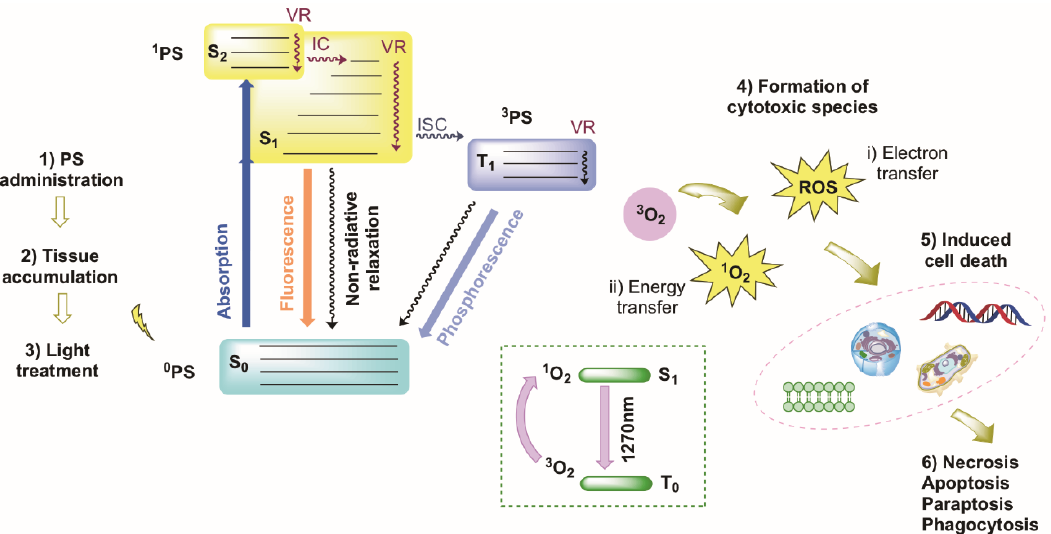
Figure 3. Simplified and generalized schematic Jablonski diagram showing the mechanism of PDT. Note, that the character and the energy of the long-lived state (here T 1 ) can be modified by the metal ion complexation.